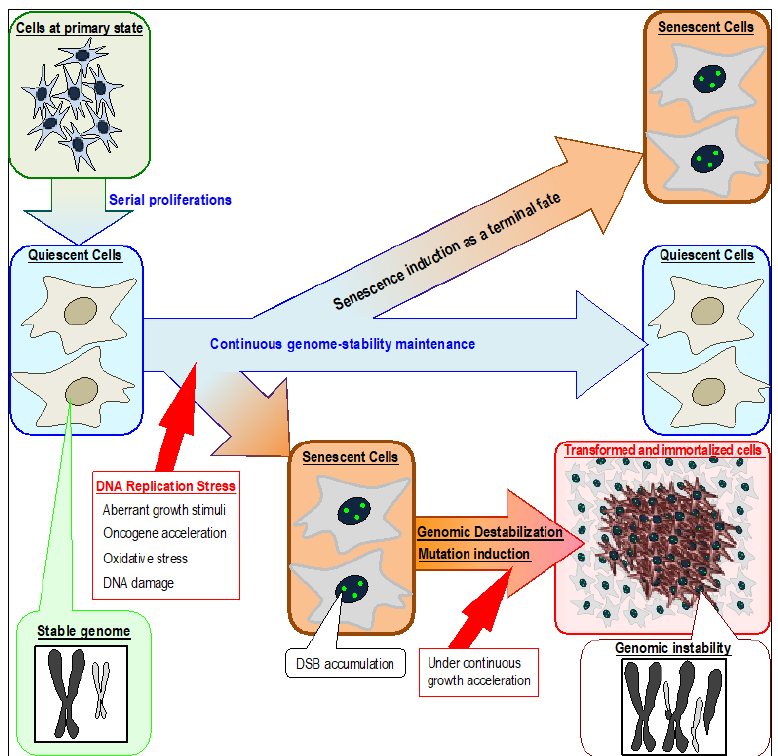
Figure 1. Induction of senescent and transformed cells triggered by DNA replication stress in association with genomic destabilization. Although quiescent cells can continuously preserve their cellular state and maintain genome stability, senescence can be induced by stresses that cause replication-fork stalling in association with persistent DSB (DNA double strand break) accumulation. Normal quiescent cells are defective in repairing DSBs caused by replication stress and are, therefore, vulnerable to genomic destabilization. Replication stress occurs in association with fork stalling, which can arise by multiple reasons that include aberrant growth stimuli, oncogene activation, oxidative stress, and DNA damage. The resultant cells accumulate DSBs and exhibit senescent characteristics. Immortalized and transformed cells usually appear after genomic